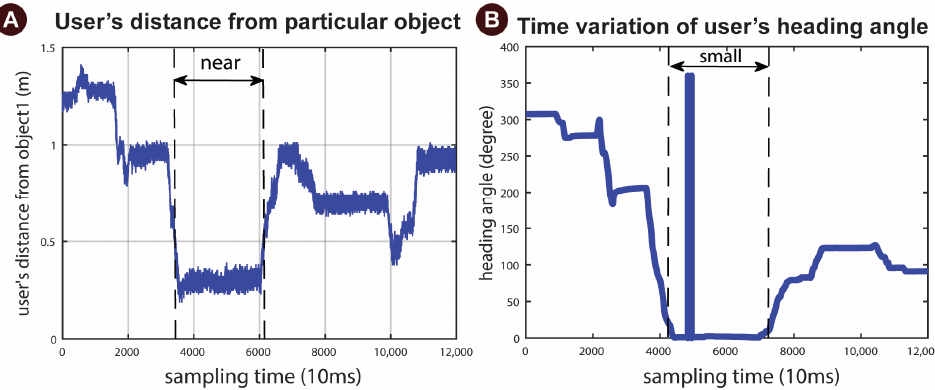
Figure 10. Result of ( A ) the time variation of the user’s distance from a particular object during the experiment, ( B ) the pattern of the time variation of the user’s heading angle during Experiment B. When the heading and distance values are members of the small fuzzy member functions, the corresponding fuzzy rule will be activated.